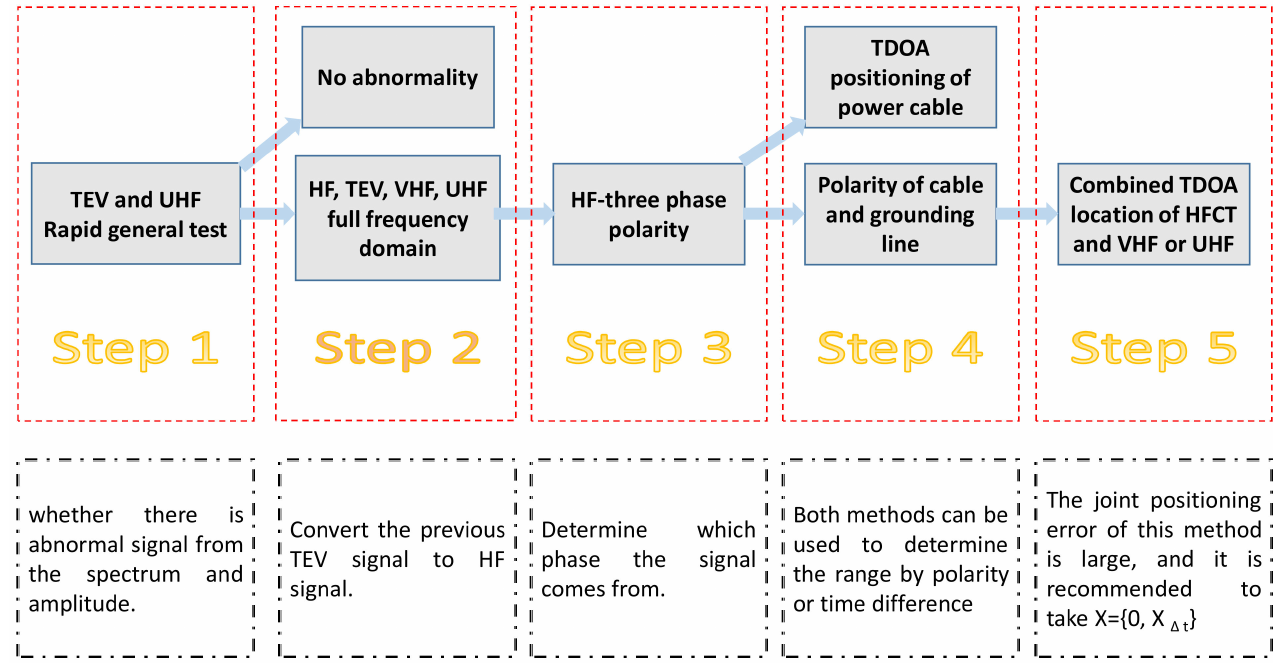
Figure 1. Diagram for the defects detection and location in GIS cable terminal.